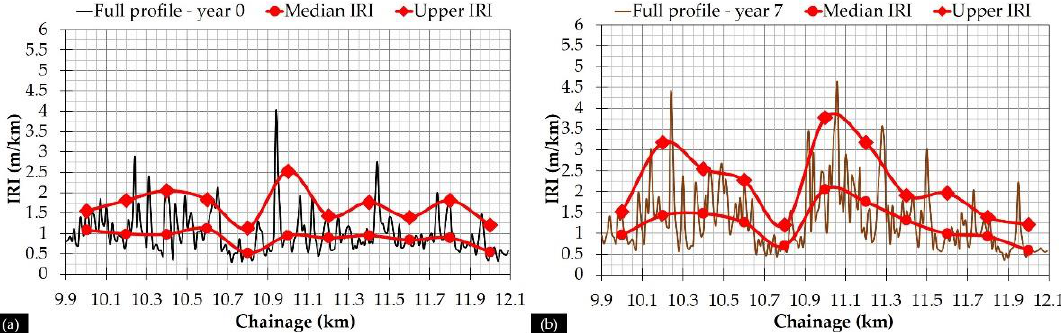
Figure 8. Full pavement profile and characteristic IRI values for ( a ) year 0, and ( b ) year